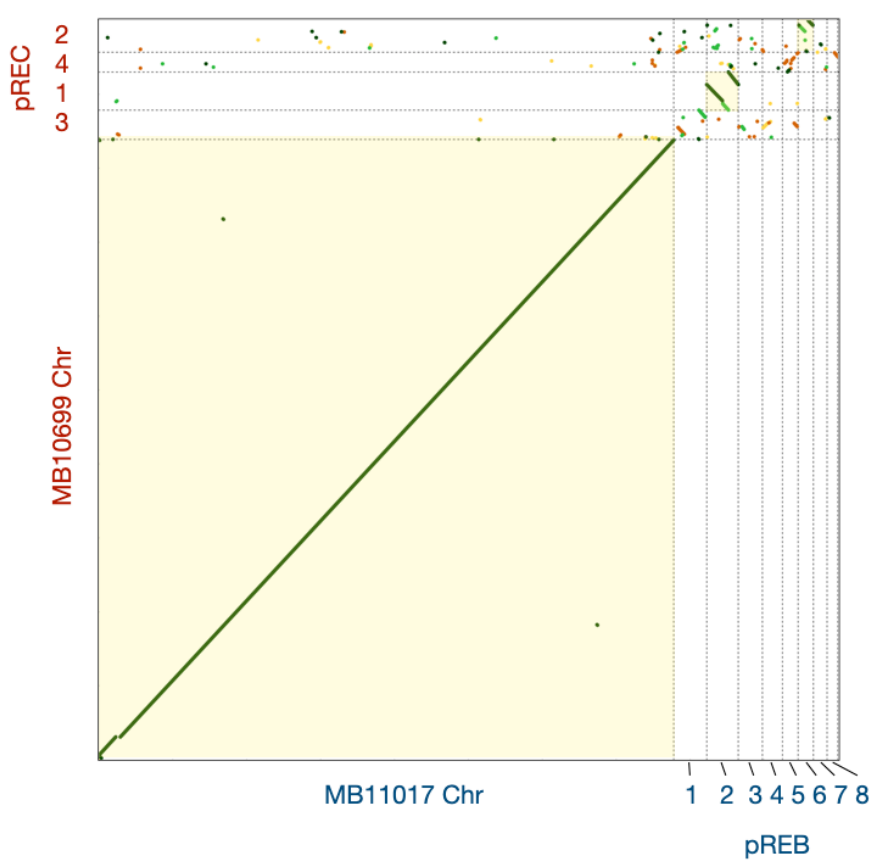
Figure 4. Dot plot analysis between A . marina MBIC10699 and MBIC11017. Dot plot alignment of A. marina MBIC10699 (vertical axis) versus A. marina MBIC11017 (horizontal axis). The color of each dot indicates the degree of identity, with 75% or more represented by green, 75–50% by light green, 50–25% by brown, and 25% or less by yellow, respectively. Matrices of combinations in which significant homology was detected are highlighted in light yellow.